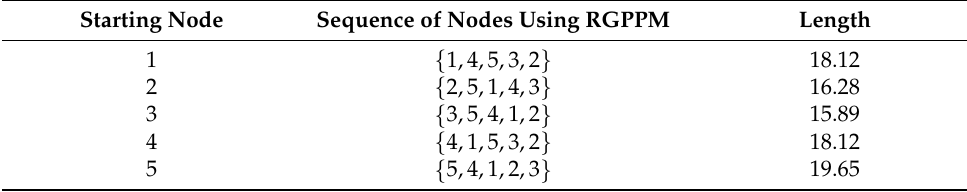
Table 4. Performance of the paths from Figure 3 by changing the start node.